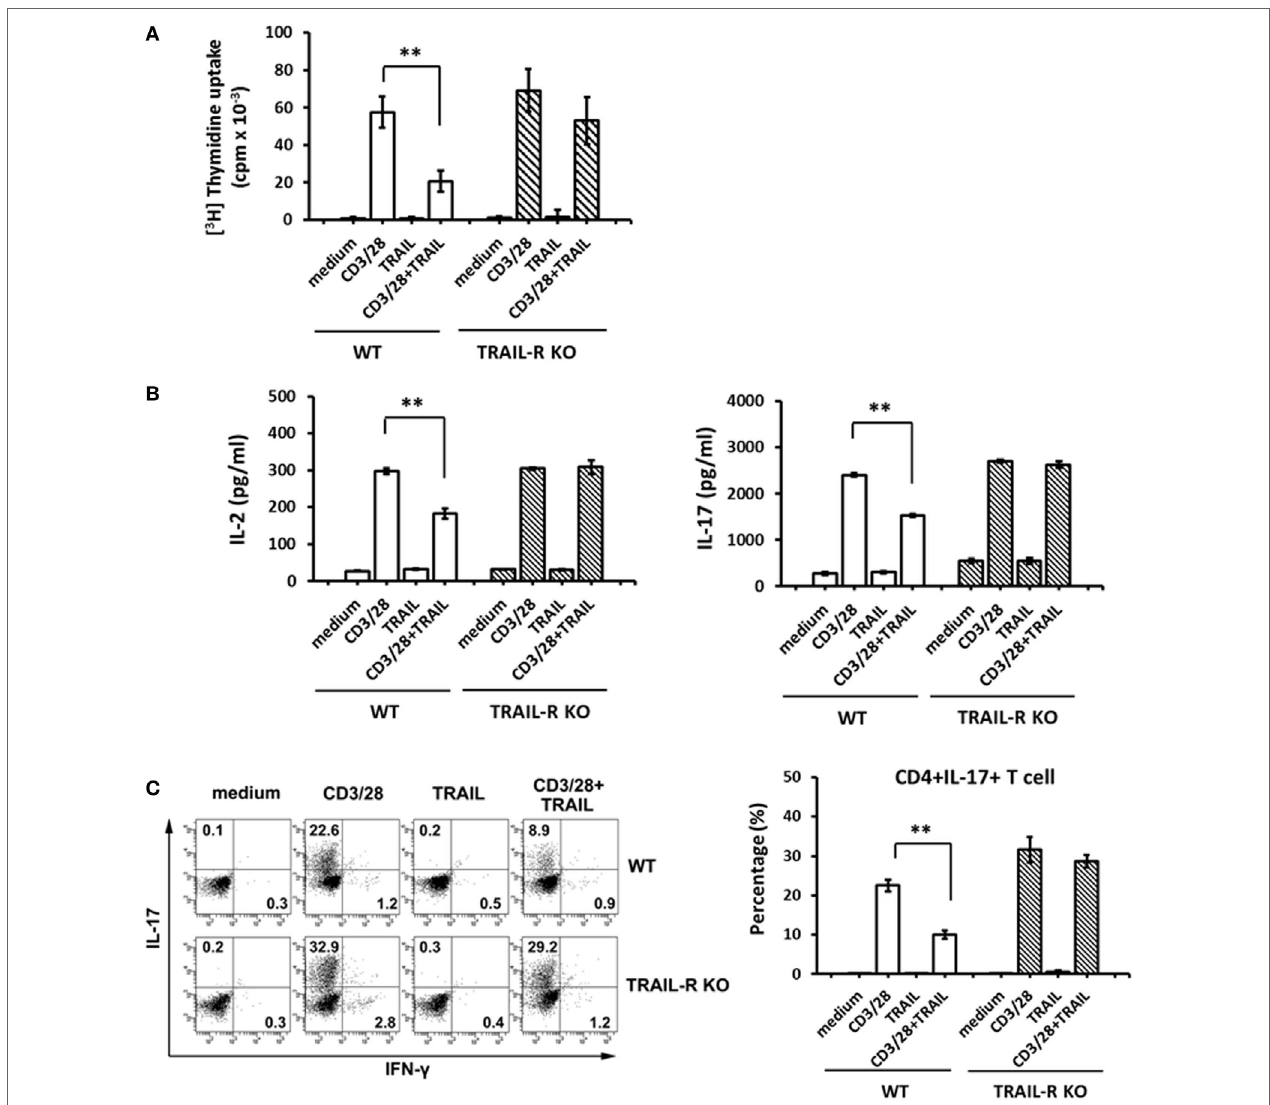
FigUre 3 | TRAIL inhibited myelin oligodendrocyte glycoprotein (MOG) 35–55 -activated T cells. Th17-polarized MOG 35–55 -activated splenic T cells were generated from wild-type (WT) and TRAIL-R KO mice after experimental autoimmune encephalomyelitis immunization, as described in Section “Materials and Methods.” (a) 10 5 MOG 35–55 -activated splenic Th17 cells were cultured in 96-well flat-bottomed plates precoated with medium, an anti-CD3 antibody (Ab; 1 µg/ml), an anti-CD28 Ab (1 µg/ml), and TRAIL (10 µg/ml), or a combination of anti-CD3/anti-CD28 Abs and TRAIL for 96 h; then [ 3 H] thymidine was added for an additional 16 h. Radioactivity (presented as cpm) was determined with a scintillation counter. ** p < 0.01 by non-parametric Mann–Whitney U -test. (B) 2 × 10 5 MOG 35–55 -activated splenic Th17 cells were cultured in 96-well flat-bottomed plates precoated with medium, anti-CD3/anti-CD28 Abs, and TRAIL, or a combination of anti-CD3/ anti-CD28 Abs and TRAIL for 24 h. Supernatants were collected and assayed for interleukin (IL)-2 (left panel) and IL-17 (right panel) concentrations by an enzyme-linked immunosorbent assay. Data are shown as the mean ± SD of triplicate samples. ** p < 0.01 by non-parametric Mann–Whitney U -test. (c) IL-17 and interferon (IFN)- γ production by MOG 35–55 -activated splenic Th17 cells were measured by intracellular cytokine staining following stimulation with medium, anti-CD3/ anti-CD28 Abs, and TRAIL, or a combination of anti-CD3/anti-CD28 Abs and TRAIL for 24 h. Data are representative of three independent experiments (left panel), and percentages of CD4 + IL-17 + cells were quantified (right panel). ** p < 0.01 by non-parametric Mann–Whitney U